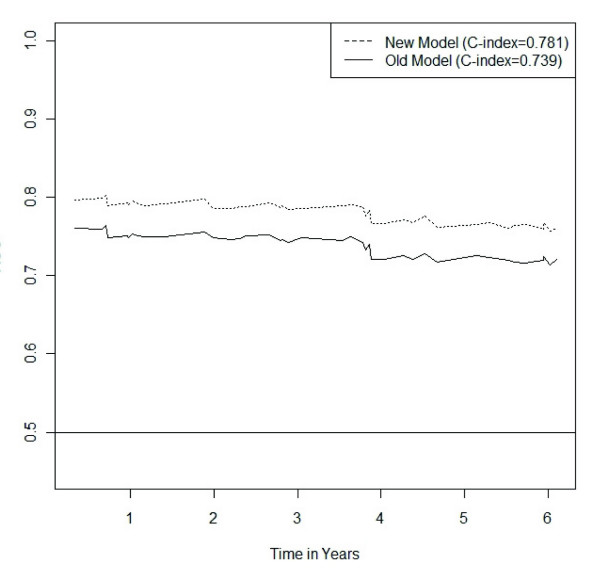
Variation of the predictive power depending on survival time. The new Cox-regression model containing BTG2 expression, HER2 expression, patient age and Ki67 expression performed better, i.e. revealed higher prediction accuracy, than a Cox-regression model containing the currently used prognostic markers that gained statistical significance (HER2 expression, and patient age). This difference in predictive power was stable, independent of survival time.